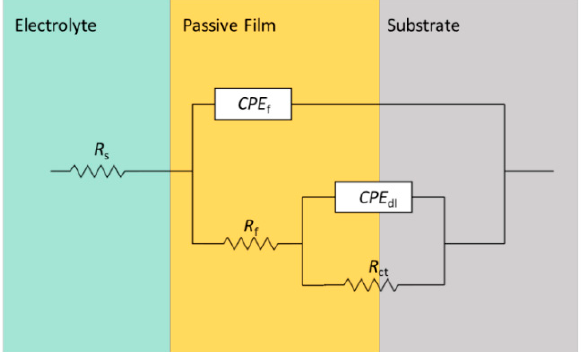
Figure 1. Nyquist plots of NaNO 2 and NaNO 3 obtained in simulated concrete pore solution contaminated with 0.6 M NaCl under constant temperature of ( a ) 25 °C, ( b ) 35 °C, and ( c ) 45 °C.